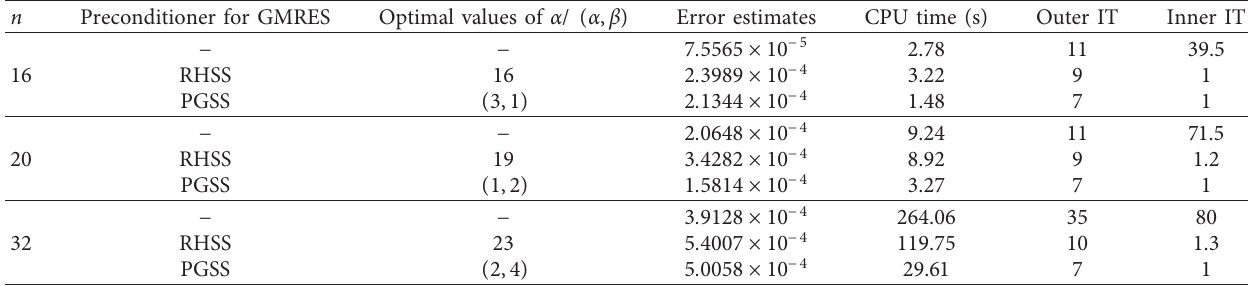
Table 11: Numerical results of preconditioned inexact Newton methods for v � 1 and η � 0.2. n Preconditioner for GMRES